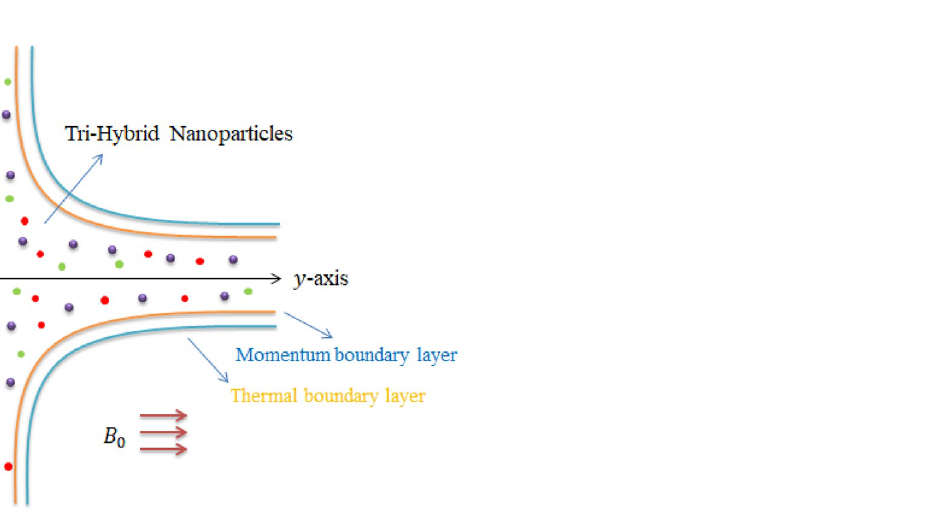
Figure 2. Model of 2D-streching